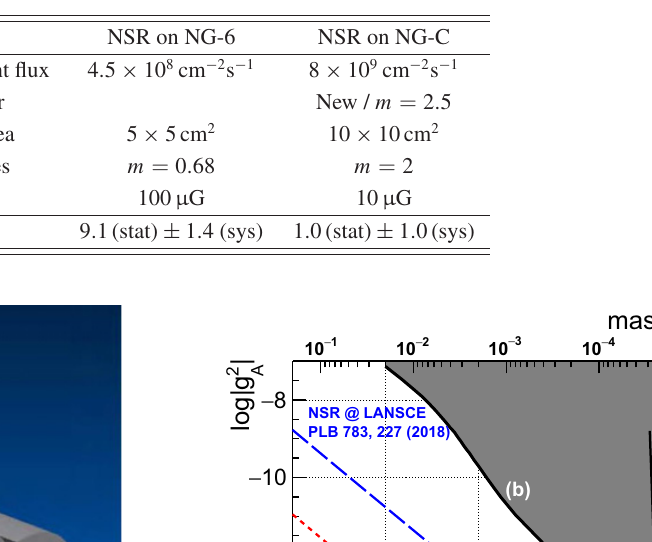
Table 1. Summary of the upgraded and new components for NSR experiment on NG-C compared with those of NSR on NG-6.